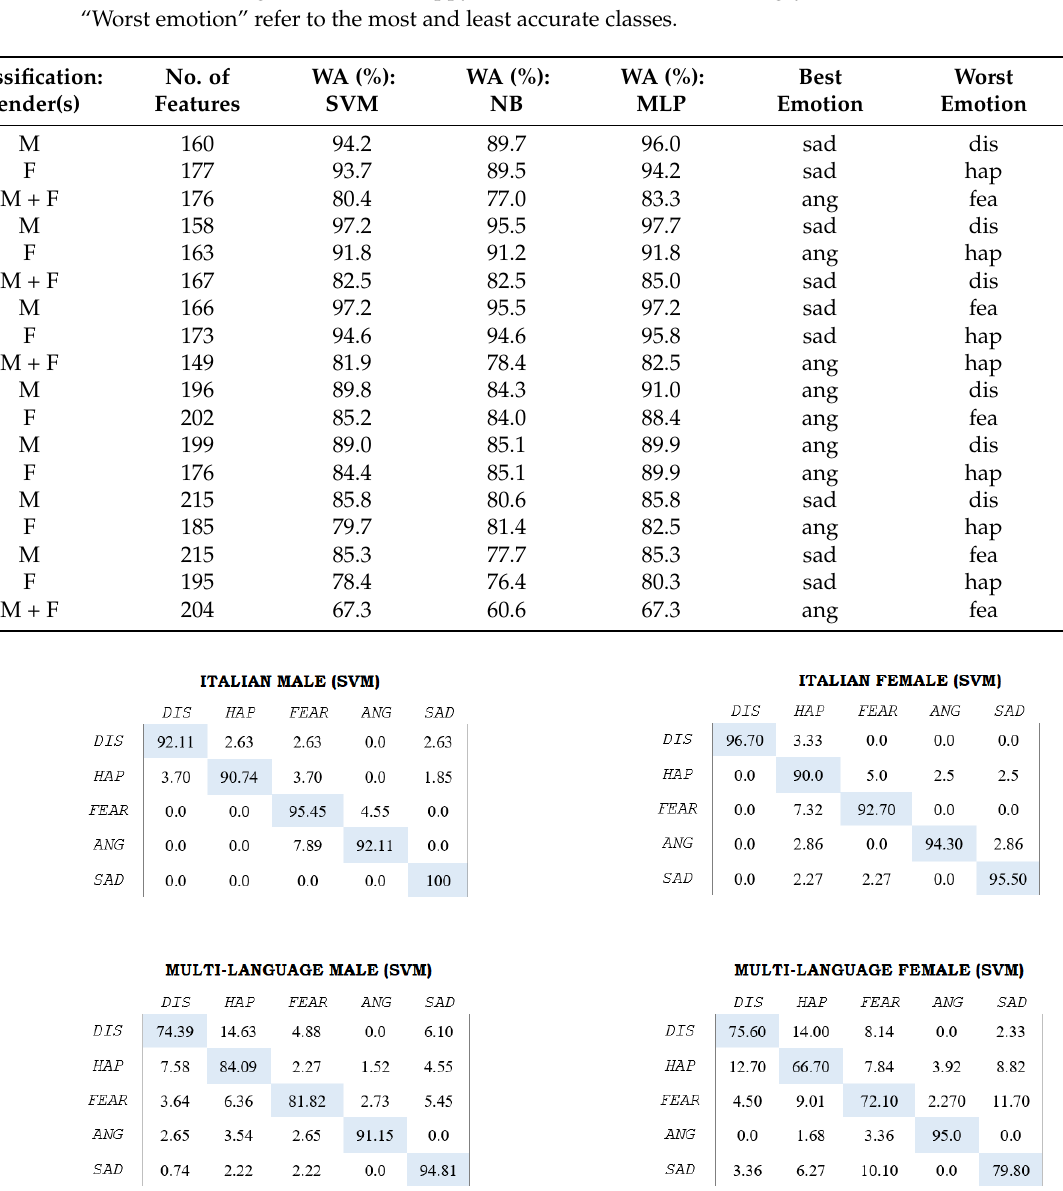
Figure 3. Confusion matrices for the SVM classifier for the It M, It F, All M and All F comparisons. Emotion labels are thus abbreviated: “DIS” = Disgust; “HAP” = Happy; “FEAR” = Fear; “ANG” = Angry; “SAD” = Sad.